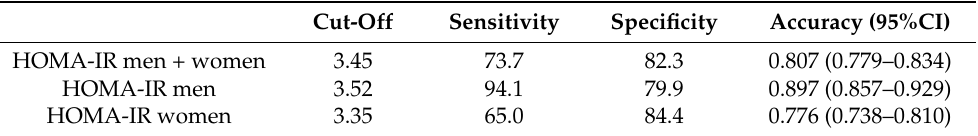
Table 7. The homeostasis model assessment of insulin resistance cut-offs for the diagnosis of type